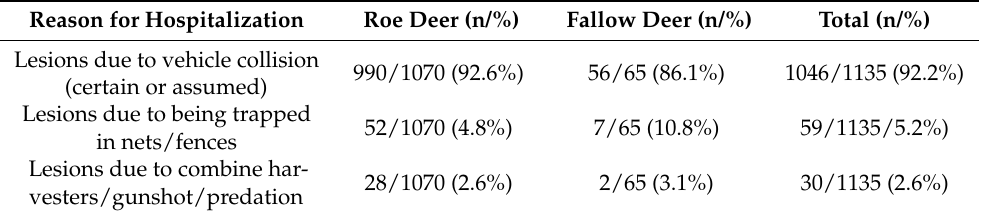
Table 3. Reasons for hospitalization expressed as the number and proportions (n/%) of roe deer and fallow deer, and total population.